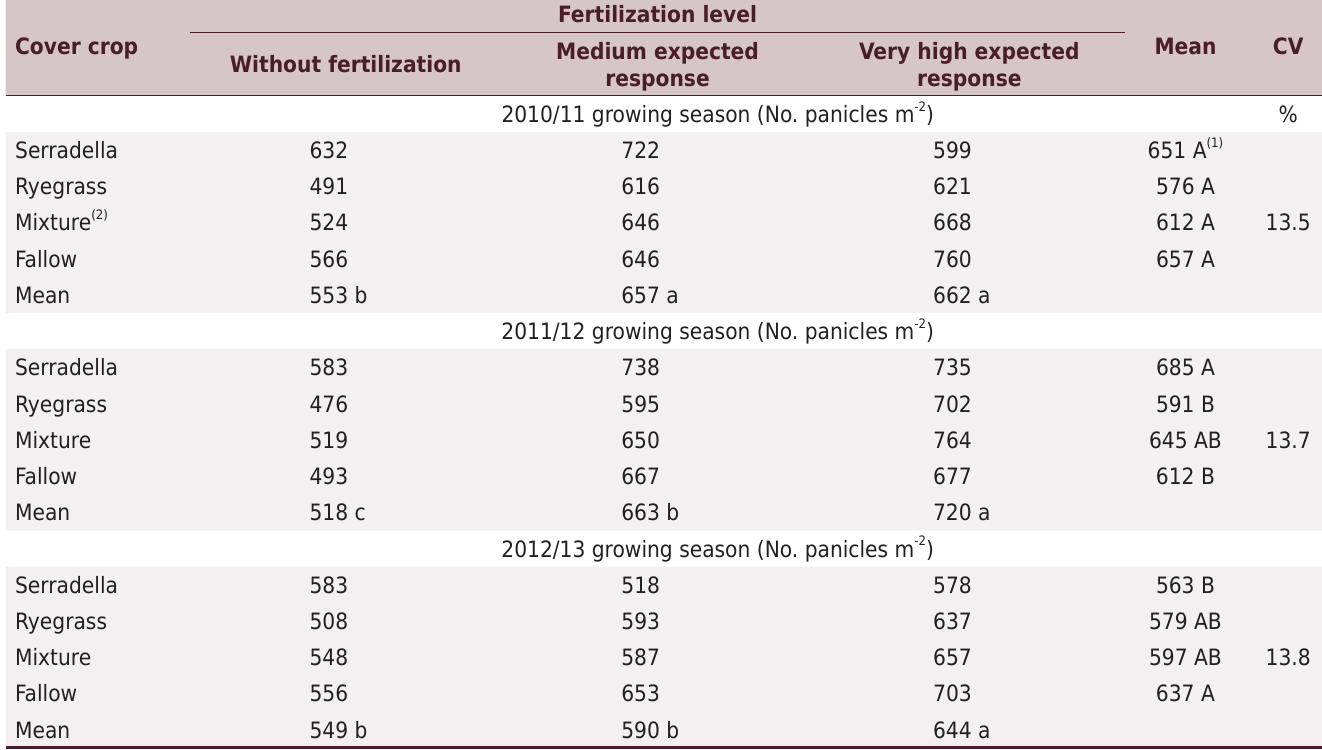
Table 5. Number of panicles per area in rice grown in succession to different cover crops and at different fertilization levels Cover crop